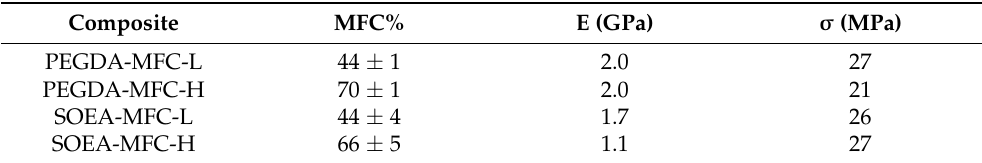
Table 2. Tensile properties of PEGDA-based and SOEA-based composites with different compositions: Young’s modulus, E , and tensile strength, σ .